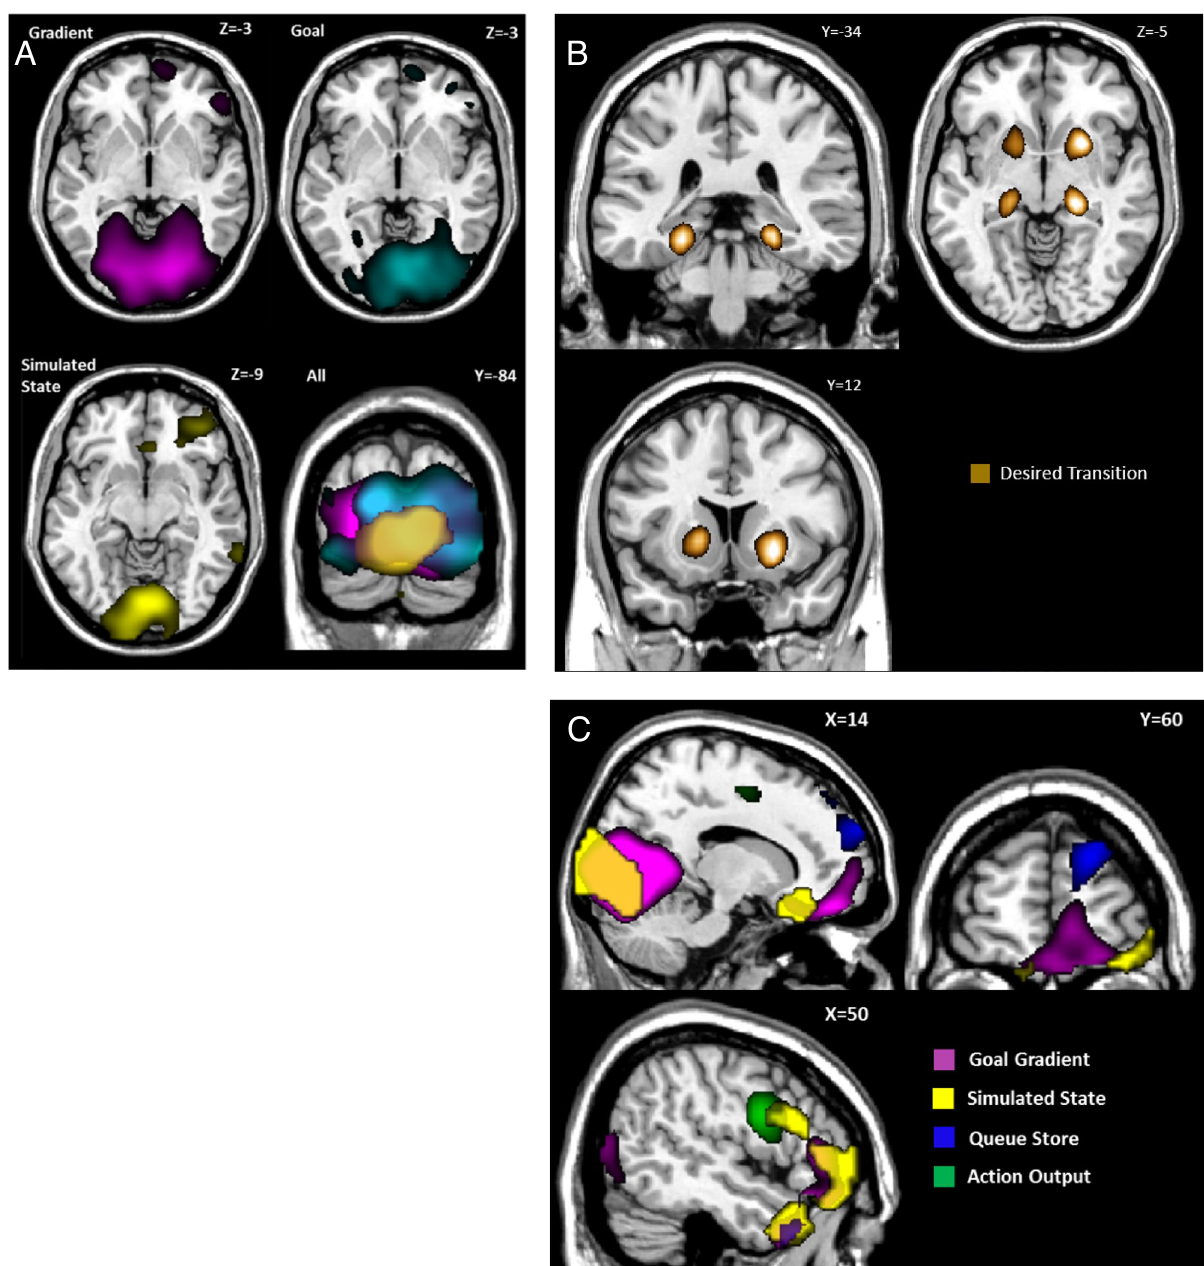
Figure 4. Representational Similarity Analysis of model layers vs. human subjects performing the same Treasure Hunt task, with the same conditions and RSA analysis as in Fig. 3. ( A ) Population Z maps showing significant regions of similarity to model layers in visual cortex. The peak regions of similarity for goal-gradient and goal overlap substantially, primarily in bilateral cuneus, inferior occipital gyrus, and lingual gyrus. The simulated-state layer displayed significantly similar activity to that in a smaller medial and posterior region. Statistical thresholding and significance are the same as Fig. 3. ( B ) Z map showing significant regions of similarity to the desired-transition layer. Similarity peaks were observed for desired-transition in bilateral hippocampal gyrus as well as bilateral caudate and putamen. The desired-transition map displayed here was visualized at p < 0.00001 for clarity. ( C ) Z maps showing significant regions of similarity to the model layers in frontal cortex. Similarity peaks were observed for queue-store in superior frontal gyrus (BA10). Action-output activity most closely resembled activity in inferior frontal gyrus (BA9), while simulated-state and goal-gradient patterns of activity were more anterior (primarily BA45). Similarity between activity in the latter two layers and activity in OFC, visual cortex, and temporal pole is also